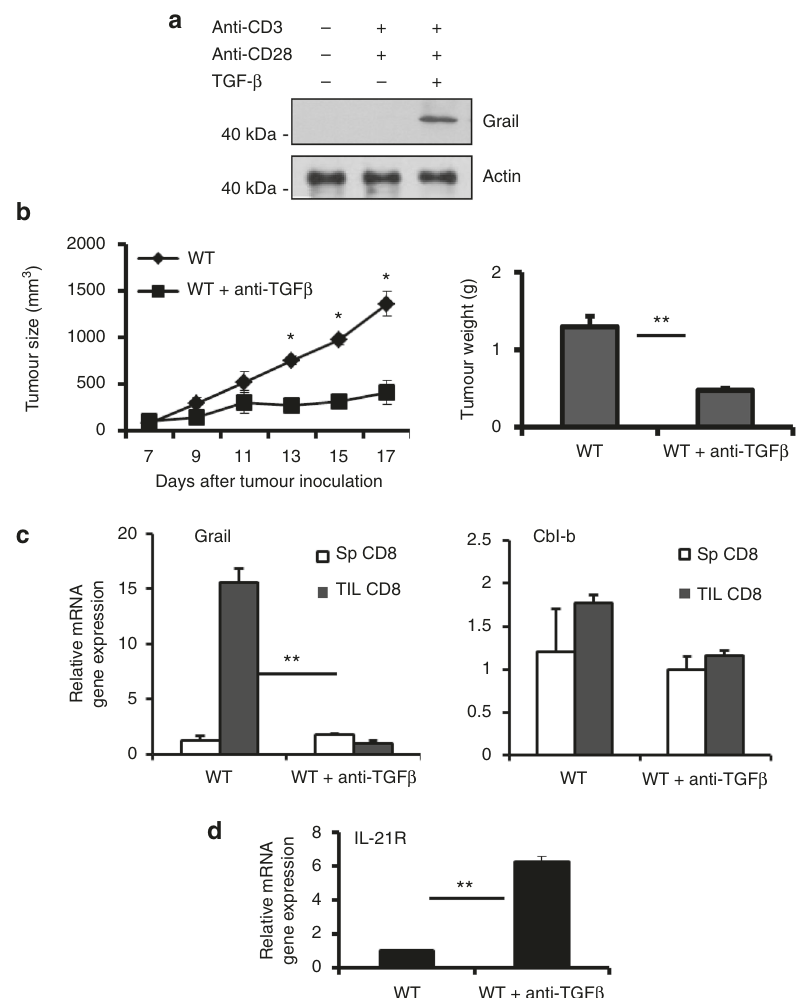
Fig. 6 Regulation of Grail expression by TGF- β in CD8 + TILs. a FACS-sorted naive CD8 + T cells were activated with plate-bound anti-CD3/anti-CD28 in the presence or absence of TGF- β , followed by western blot to detect Grail levels. β -actin was used as a loading control. b WT mice were injected with rIgG or anti-TGF- β blocking antibodies on day 5, 7 and 9 after EG-7 inoculation and monitored daily for tumour growth. On day 17, tumours were isolated from each group and weight determined as in Fig. 1. ( n = 3 independent experiments with fi ve mice per group). c , d CD8 + T cells from spleens and TILs were FACS-sorted and restimulated with plate-bound anti-CD3 for 4 h. The mRNA expression of Grail and Cbl-b ( c ) and IL-21R ( d ) were detected by RT-PCR analysis. Results for target genes are presented after normalising to β -actin and shown as mean ± SEM. The results shown are representative of three independent experiments. * p < 0.05, ** p < 0.01 as determined using a Student ’ s